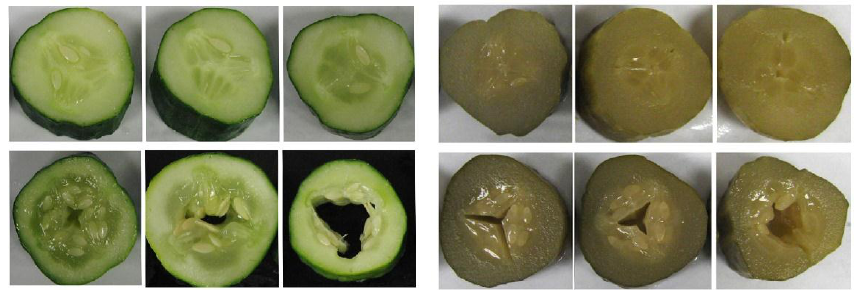
Figure 16. Example of normal ( top ) and defective ( bottom ) slices of fresh pickling cucumbers ( left ) and pickles ( right ). Reproduced with permission from [84], Copyright Elsevier, 2010.